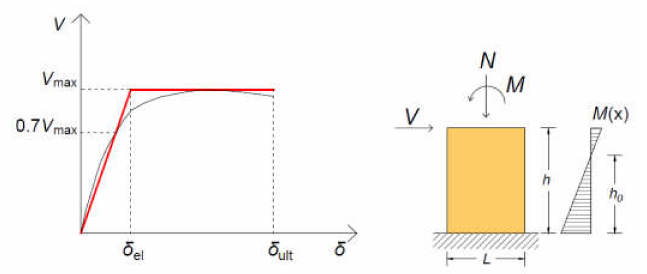
Figure 3. Modelling the shear behavior of masonry panels via bilinear